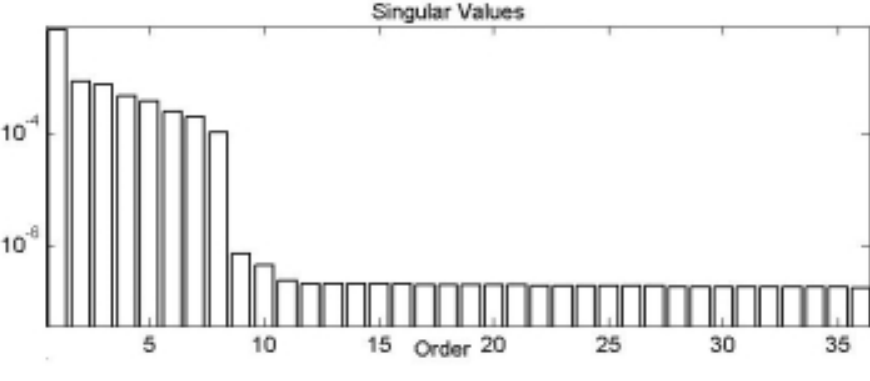
Fig. 2. Singular value plot for the numerical